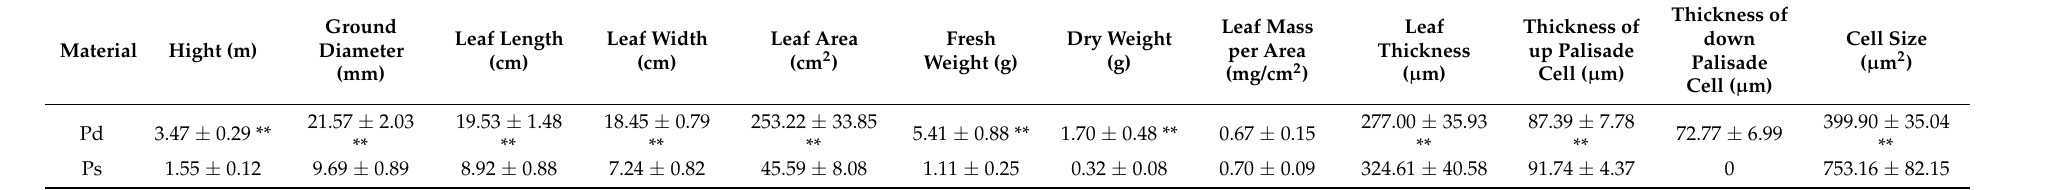
Table 1. Phenotypic character of P. deltoides ‘Danhong’ and P. simonii